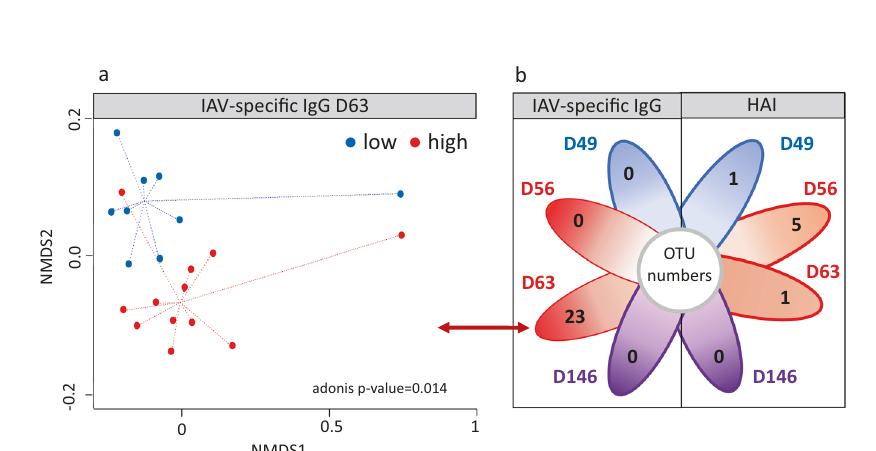
Fig. 3 Links between the composition of pre-vaccination fecal microbiota at D28 and vaccine response levels at different time points. a NMDS representation of individuals corresponding to high (red dots) and low (blue dots) producers of IAV-speci fi c IgG at D63. b Number of OTUs that were differentially abundant between high and low responders de fi ned by IAV-speci fi c IgG or HAI at D49 (blue), D56 (red), D63 (red), and D146 (purple). Arrows connect the number of differentially abundant OTUs with the NMDS representation of the corresponding high and low groups used for the differential abundance analysis. NMDS ordination is based on Bray-Curtis distance. The p -values of the Adonis test between high and low groups are indicated (corresponding data available in Table 2 and Supplementary Data